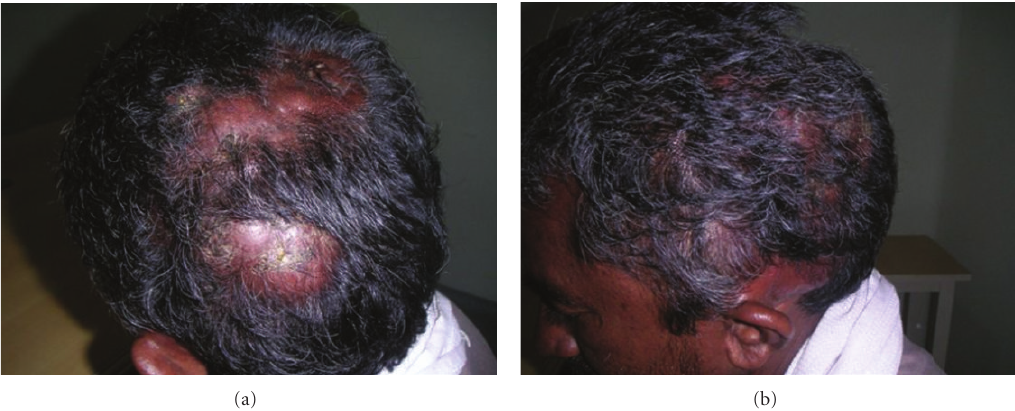
Figure 1: (a) Scalp mass in the left temporoparietal region. (b) Scalp mass in the left temporoparietal region.